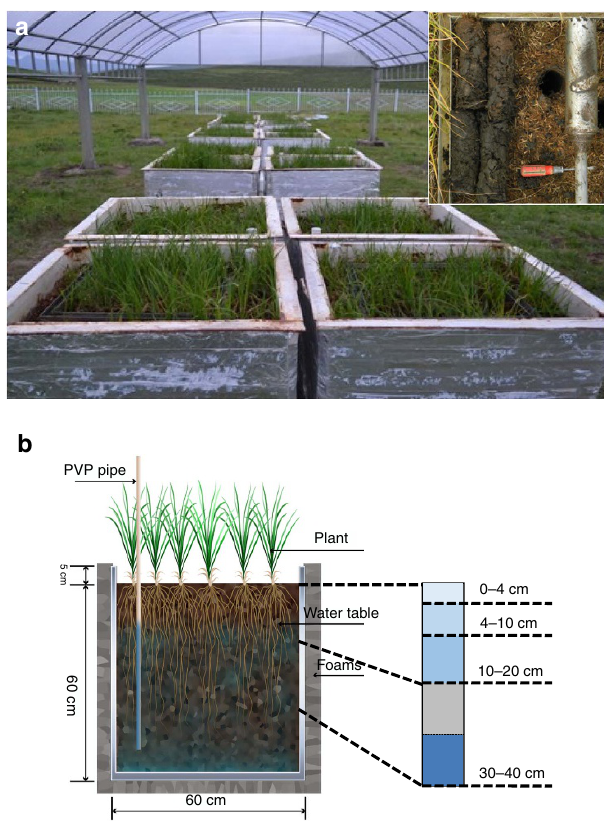
Figure 1 | Pictures and design of the water-table decline experiment. ( a ) Picture of the mesocosm experiment with control and water-table decline treatments ( n ¼ 4) at the Haibei Research Station, Qinghai Province, China. Picture of soil cores is shown on the upper right corner. ( b ) Cartoon diagram of the experimental design and soil sampling at different depth (modified from Wang et al. 36